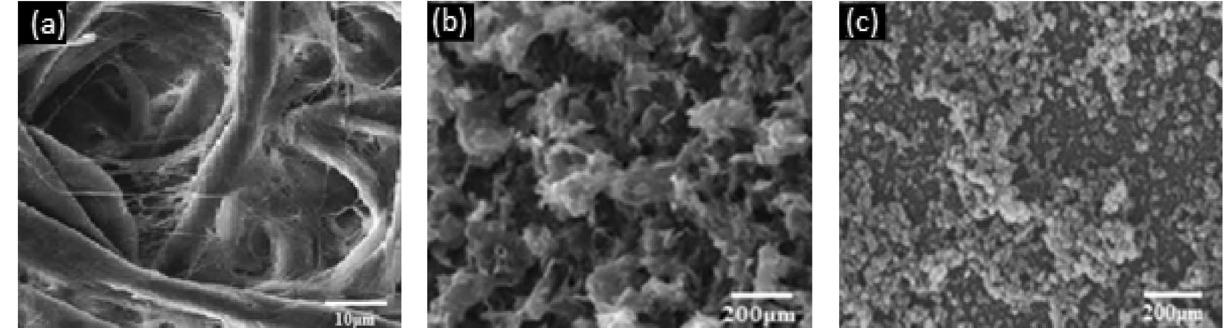
Figure 5. ( a ) SEM image of Uncoated cellulose paper; SEM image of paper spray coated with ( b ) Ti1 ink solution, ( c ) Ti2 ink solution. (EVO 50 (CARL Zeiss) system).